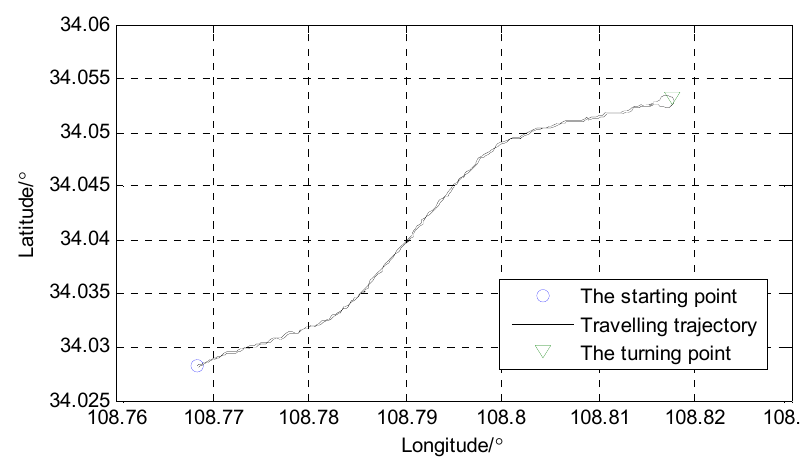
Figure 4. The position coordinates of the vehicle travelling trajectory.